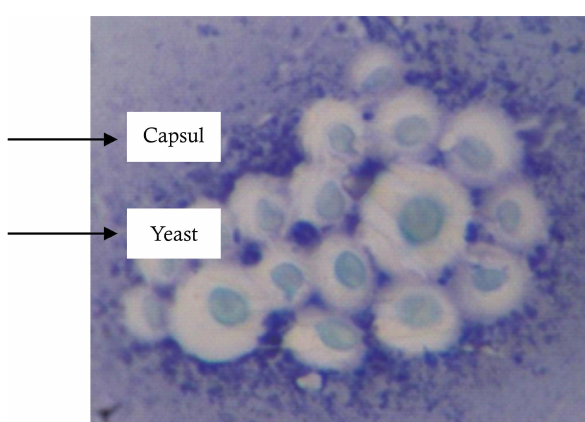
Fig 1. Capsulated yeast on India ink staining Fig 2. Colorless and slightly cloudy